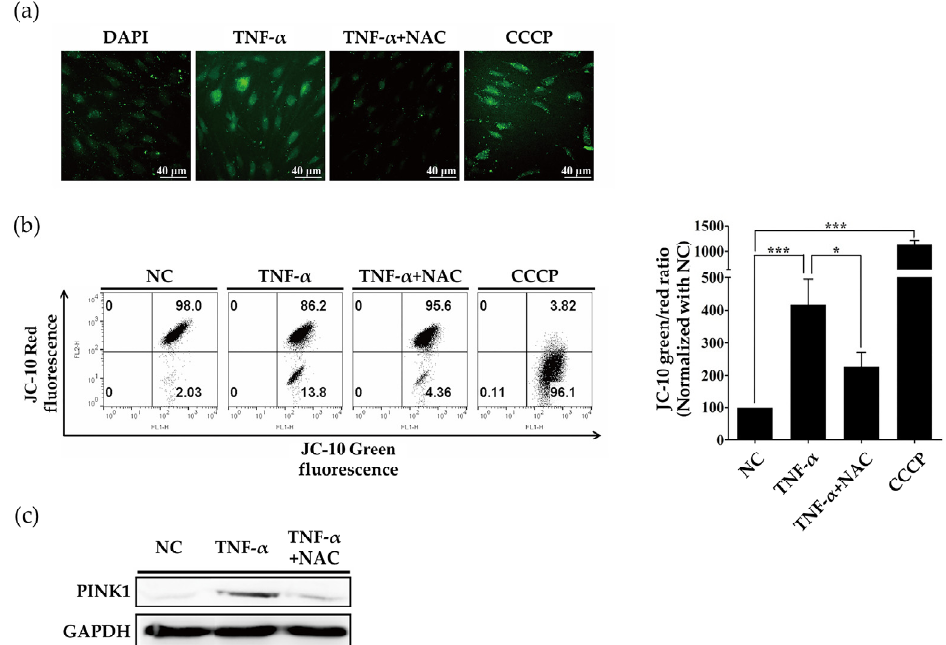
Figure 2. TNF- α stimulation increases ROS levels to induce PINK1 accumulation in RASFs. ( a ) After pretreatment with NAC (5 mM) for 1 h, RASFs were stimulated with TNF- α (10 ng/mL) or CCCP (10 μ M) for 24 h. Cells were stained with CM-DCFDA for 30 min. Immunofluorescence revealed that TNF- α induced ROS formation and NAC quenched ROS. Data are representative of at least three independent experiments. ( b ) Cells were stained with JC-10 for 30 min and subjected to flow cytometry. Data are representative of five independent RASF preparations. * p < 0.05; *** p < 0.001. ( c ) Western blot for PINK1 in RASFs stimulated with TNF- α (10 ng/mL) for 24 h + NAC (5 mM), revealing increased PINK1 levels with TNF- α stimulation and decreased PINK1 levels in TNF- α + NAC co-treated cells.